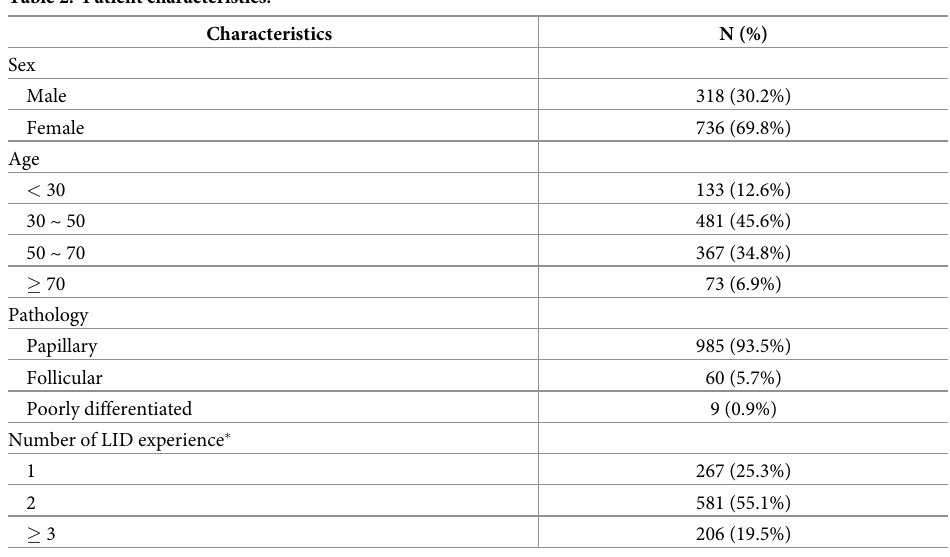
Table 2. Patient